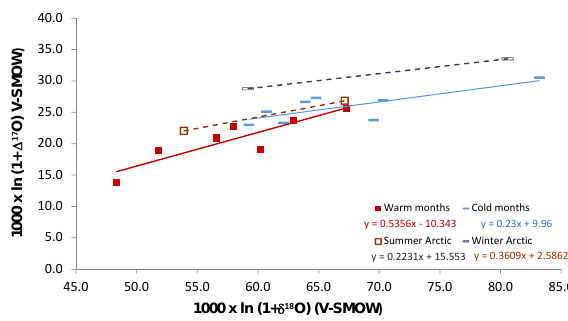
Figure 4. Isotopic results for p NO − (solid lines), compared with summer and winter trends obtained for Arctic sites (dashed lines; derived from ln (1 + δ ) in Morin et al.,